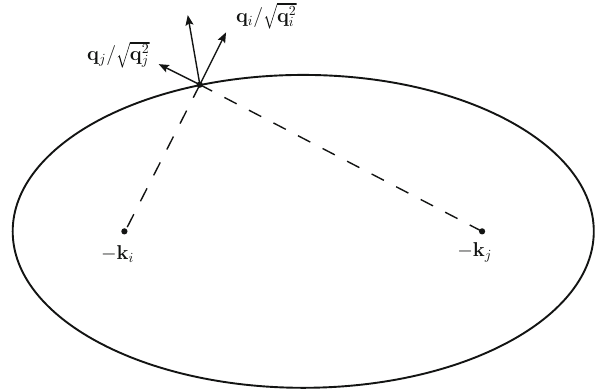
Fig. 6 Two-dimensional slice of the ellipsoid singularity of dual con- tribution i at position j . The resulting vector gives the direction of the